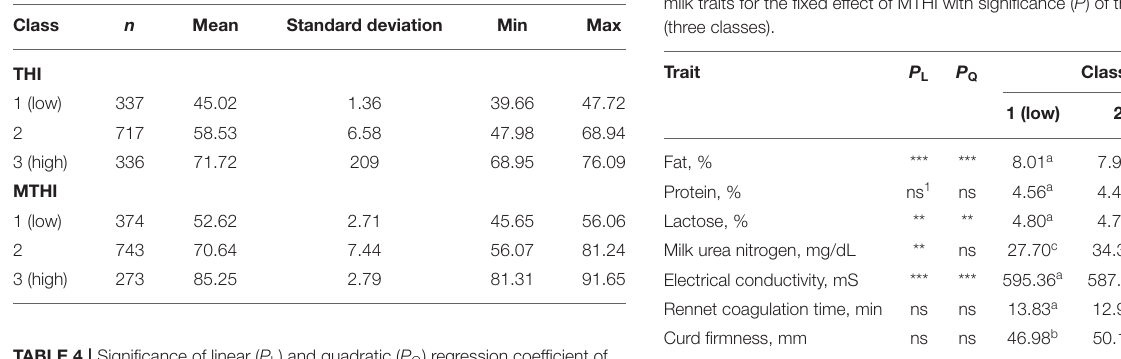
TABLE 4 | Significance of linear ( P L ) and quadratic ( P Q ) regression coefficient of temperature-humidity index (THI) and least squares means of bulk milk traits for the fixed effect of THI with significance ( P ) of the effect (three classes).